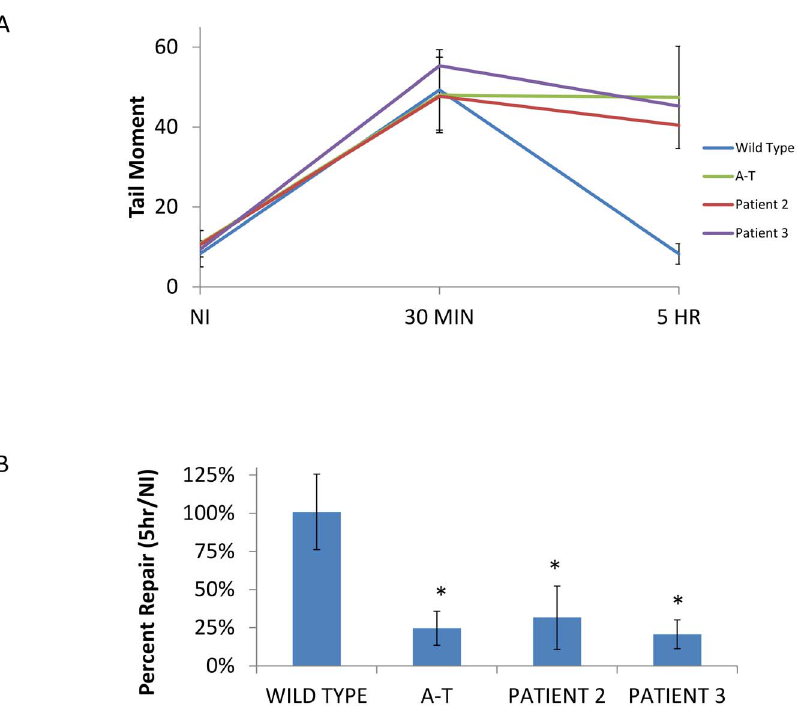
Figure 9. Neutral comet assay compatible with a DNA double-strand break repair disorder. (a). Tail moment of WT, A-T and patient cells at 0, 30 minutes and 5 hours post-irradiation. All cells show damage at 30 minutes post-irradiation. WT returns to near baseline levels after 5 hours, while A-T and patient cells show long comet tails after 5 hours, indicating significant levels of unrepaired DNA. (b). Ratio of unrepaired DNA at 5/ 0 hours. A-T as well as Patient 2 and 3 cells show statistically significantly lower levels of repair at 5 hours post-irradiation compared to wild type cells (* p , 0.05). Experiments were performed in triplicate with the average of three experiments shown. WT = wild type; A-T = ataxia-telangiectasia control.